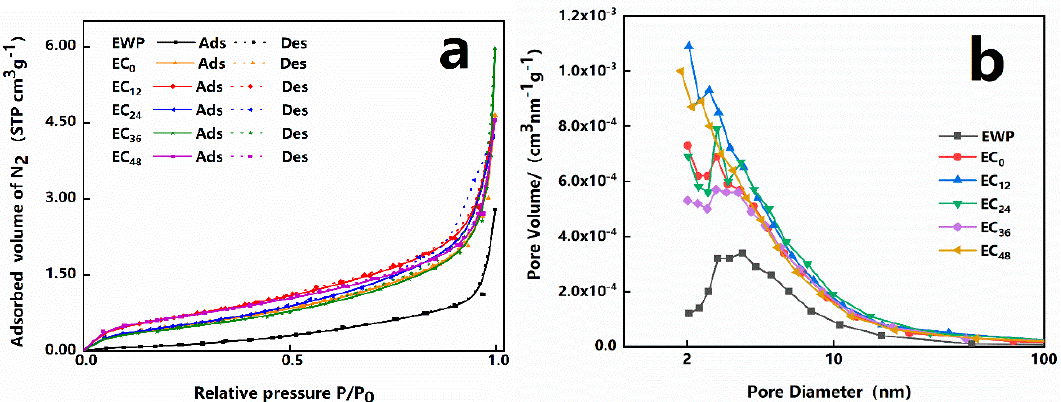
Figure 4. Nitrogen adsorption–desorption isotherms ( a ) and BJH plot ( b ) for the aerogels with different grafting degrees.